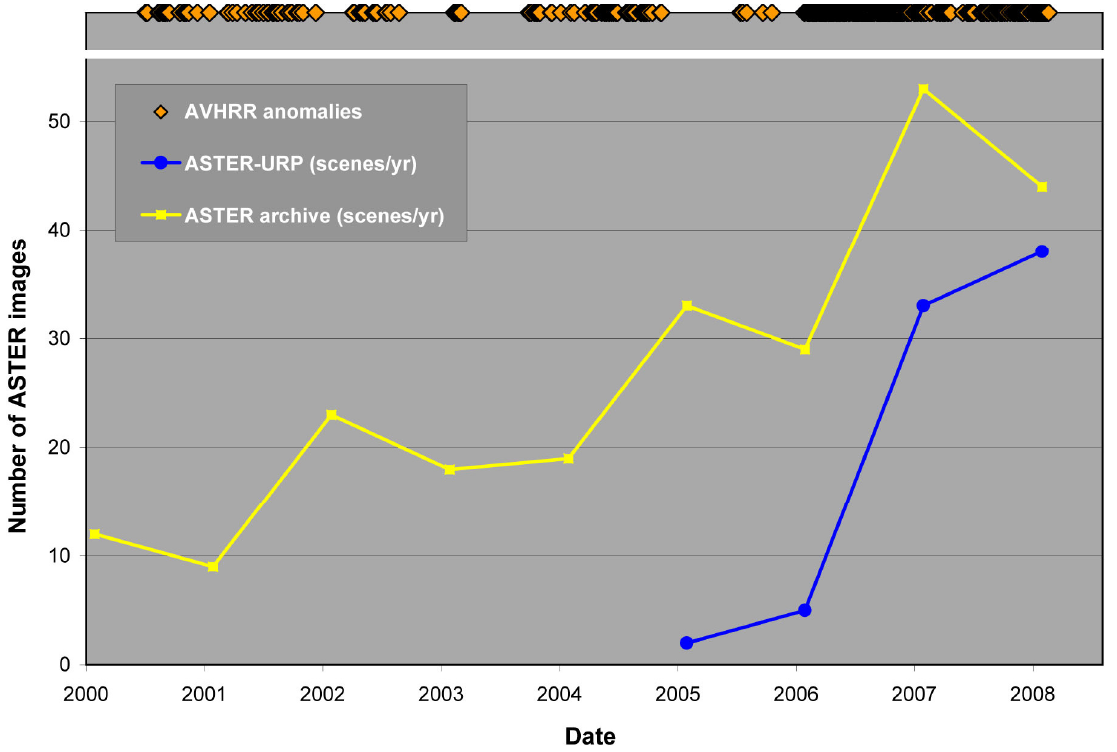
Figure 3. The record of ASTER images (graphs) and AVHRR (orange diamonds) anomalies observed from 2000 to 2009. The total number of ASTER images are averaged per year, whereas the AVHRR data are listed individually per day. Prior to the inception of the ASTER URP program in 2004 an average of 17 images per year were acquired. Following the URP start, this increased to an average of 40 images per year. The peak in images collected per year was in 2007, which also coincided with highest levels of volcanic